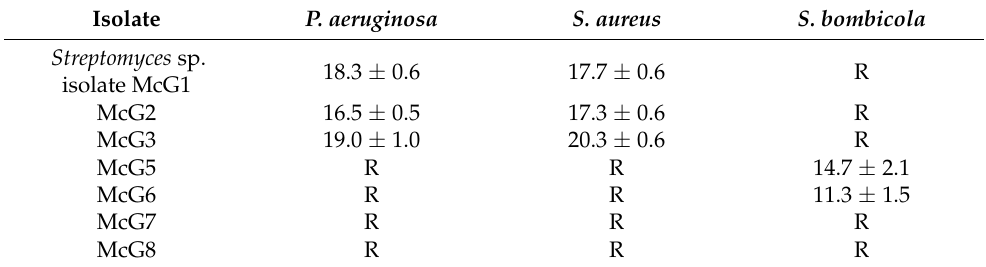
Figure 1. Boho Streptomyces spp. isolates McG1, McG2, and McG3 tested for inhibitory activity against ( a ) MRSA 43,300 ( b ) P. aeruginosa (PA01). Isolates McG5 and McG6 tested for inhibitory activity against ( c ) S. bombicola . Control wells contain gentamicin (GEN 20 µ g), kanamycin (KAN 20 µ g), teicoplanin (TE 20 µ g), cefoxitin (FOX 20 µ g), chlorhexidine (CHG, 40 µ g), and control blank (B). Tests performed three or more times. Table 2. The inhibitory potential of the Streptomyces isolates from the Boho clay against S. aureus (MRSA 43300), P. aeruginosa (PA01), and S. bombicola . Inhibition zones recorded in millimeters (mm), resistant (R). Tests were repeated a minimum of three times.